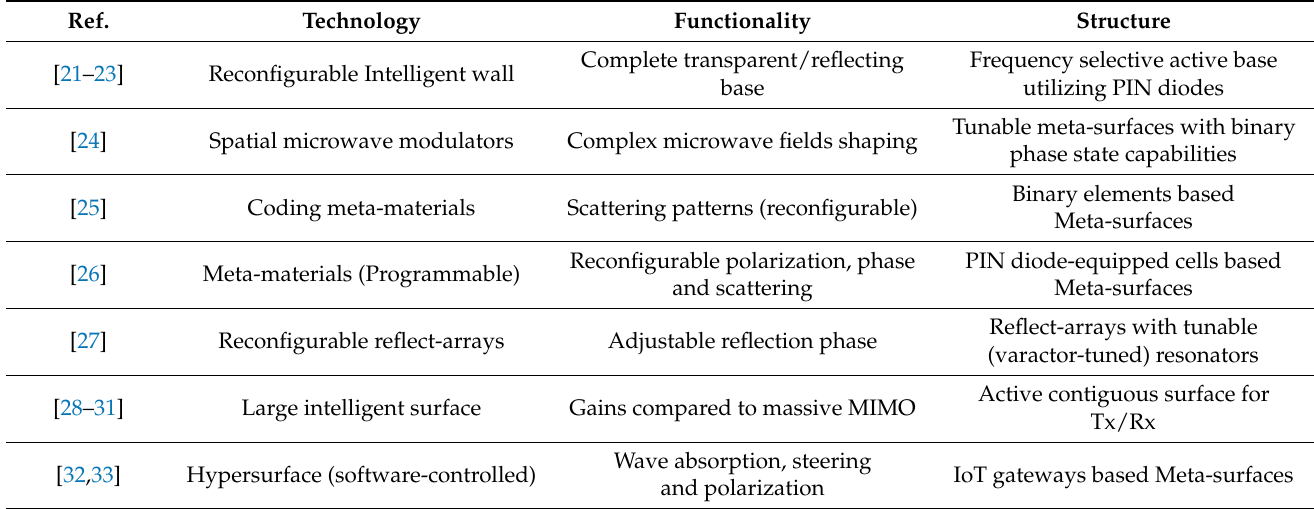
Table 1. Technologies for communication based on Intelligent surfaces.